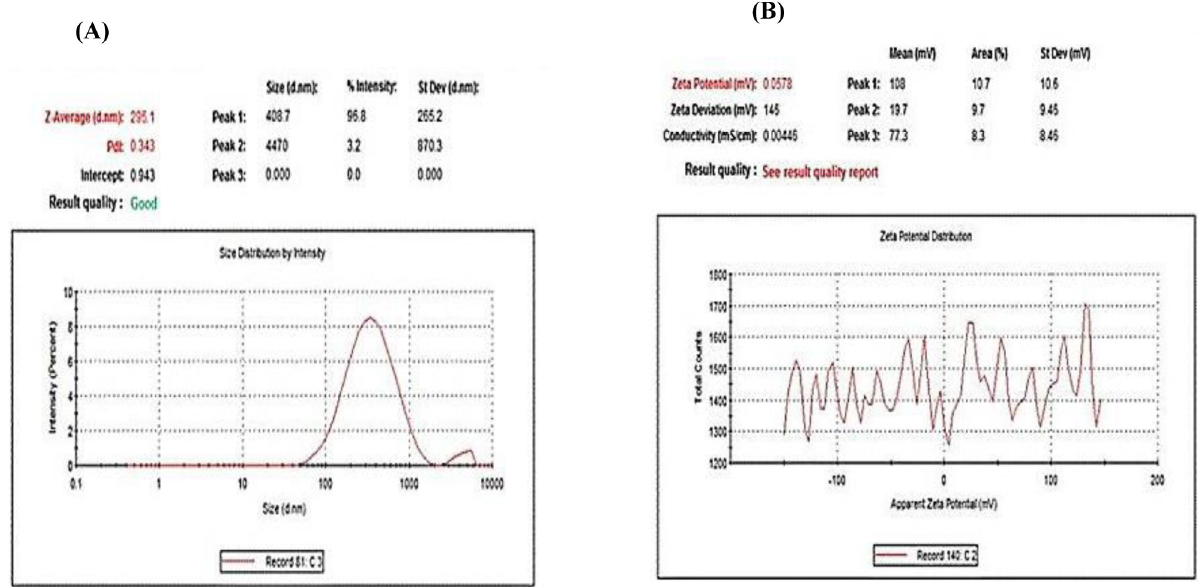
Fig 3. Zeta size images shows (A) the average particle size and (B) the potential of the synthesized (IONPs) from S . costus root extracts.